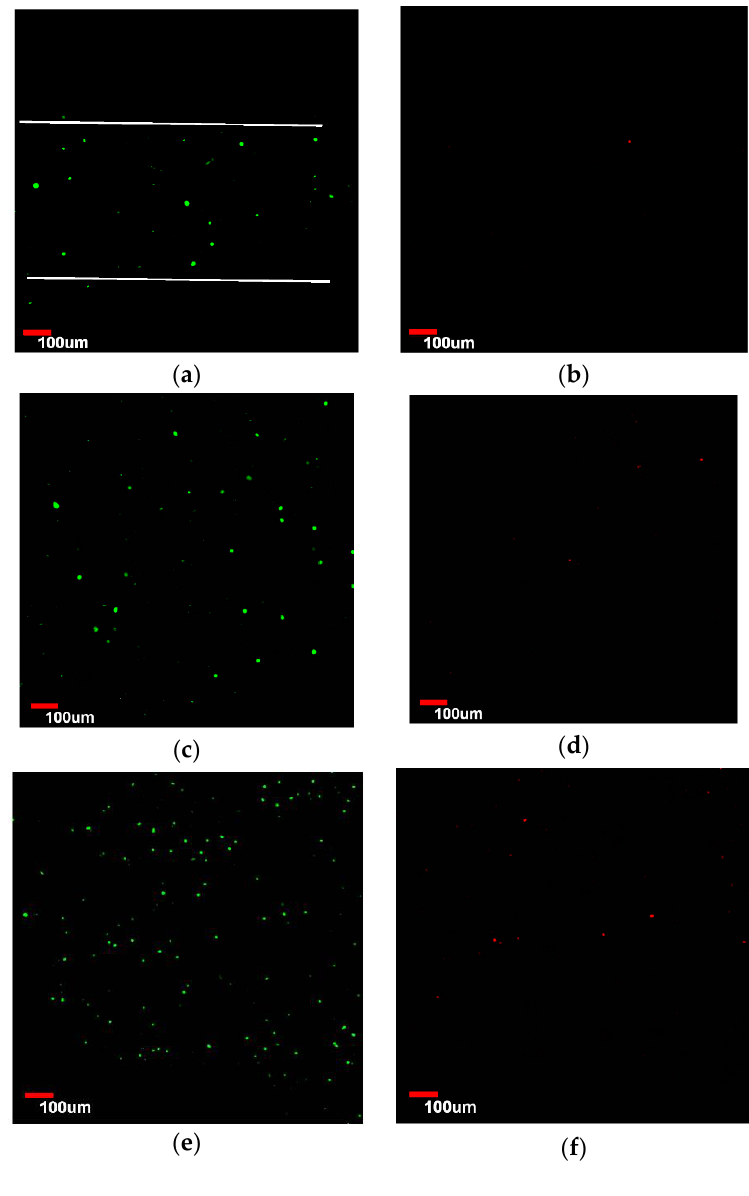
Figure 8. Laser confocal imaging of viability staining. HUVECs of the Gel-F127-PCL group labeled with Live-Dye and propidium iodide after seeding in the macrochannels in the construct with multiscale channels and imaged with confocal laser scanning microscope. Live and dead cells are fluorescent green and red, respectively. ( a , b ) About 10% dead cells were observed on day 1; ( c , d ) about 12% dead cells were visible on day 3; and ( e , f ) about 15% dead cells were obvious on day 7.